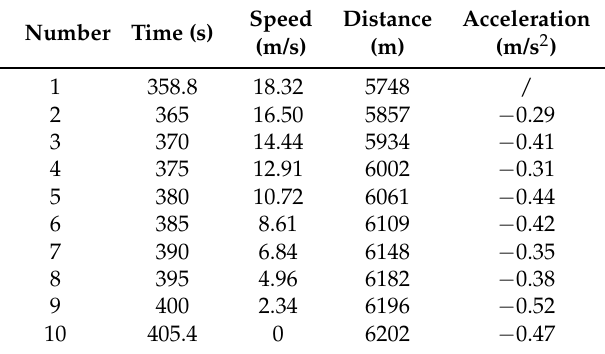
Table 8. Braking data of the Changping